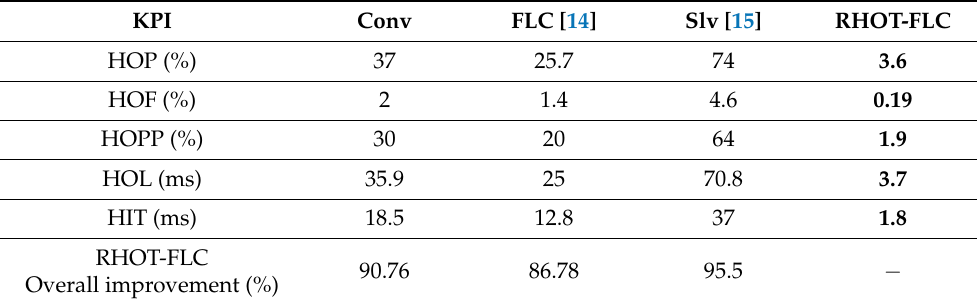
Table 4. Average HO performance for all algorithms and overall improvement of RHOT-FLC as compared to the competitive